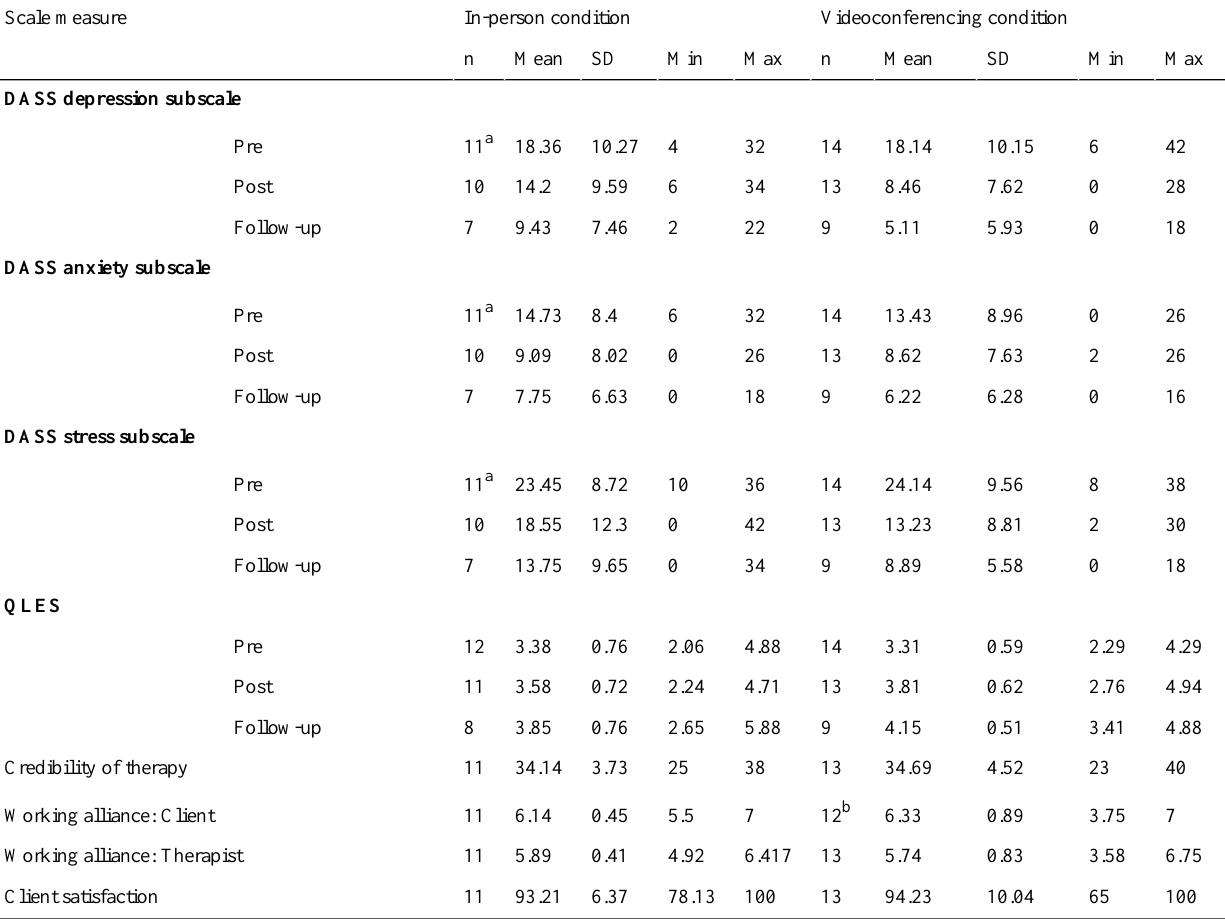
Table 3. Descriptive statistics for the scale measures in the in-person and videoconferencing conditions.